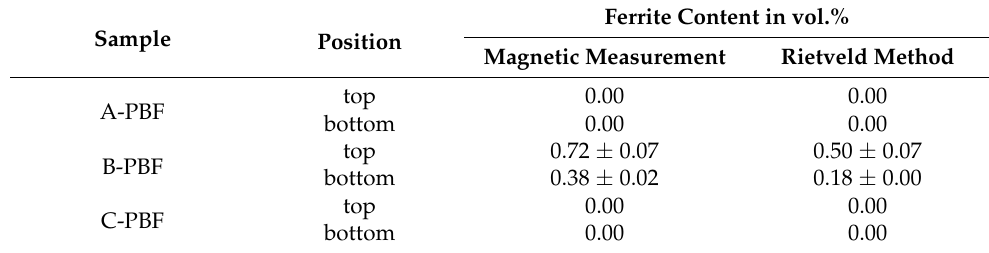
Table 5. Ferrite contents of the PBF-LB/M-processed